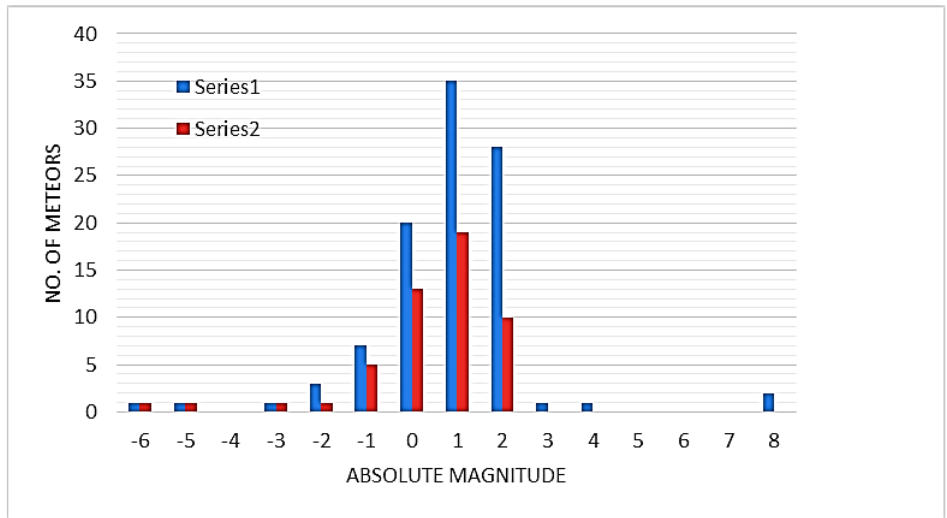
Fig. 3 The absolute magnitude distribution of the meteors observation during 5-13 August 2016. Series 2 represented Perseids meteors.